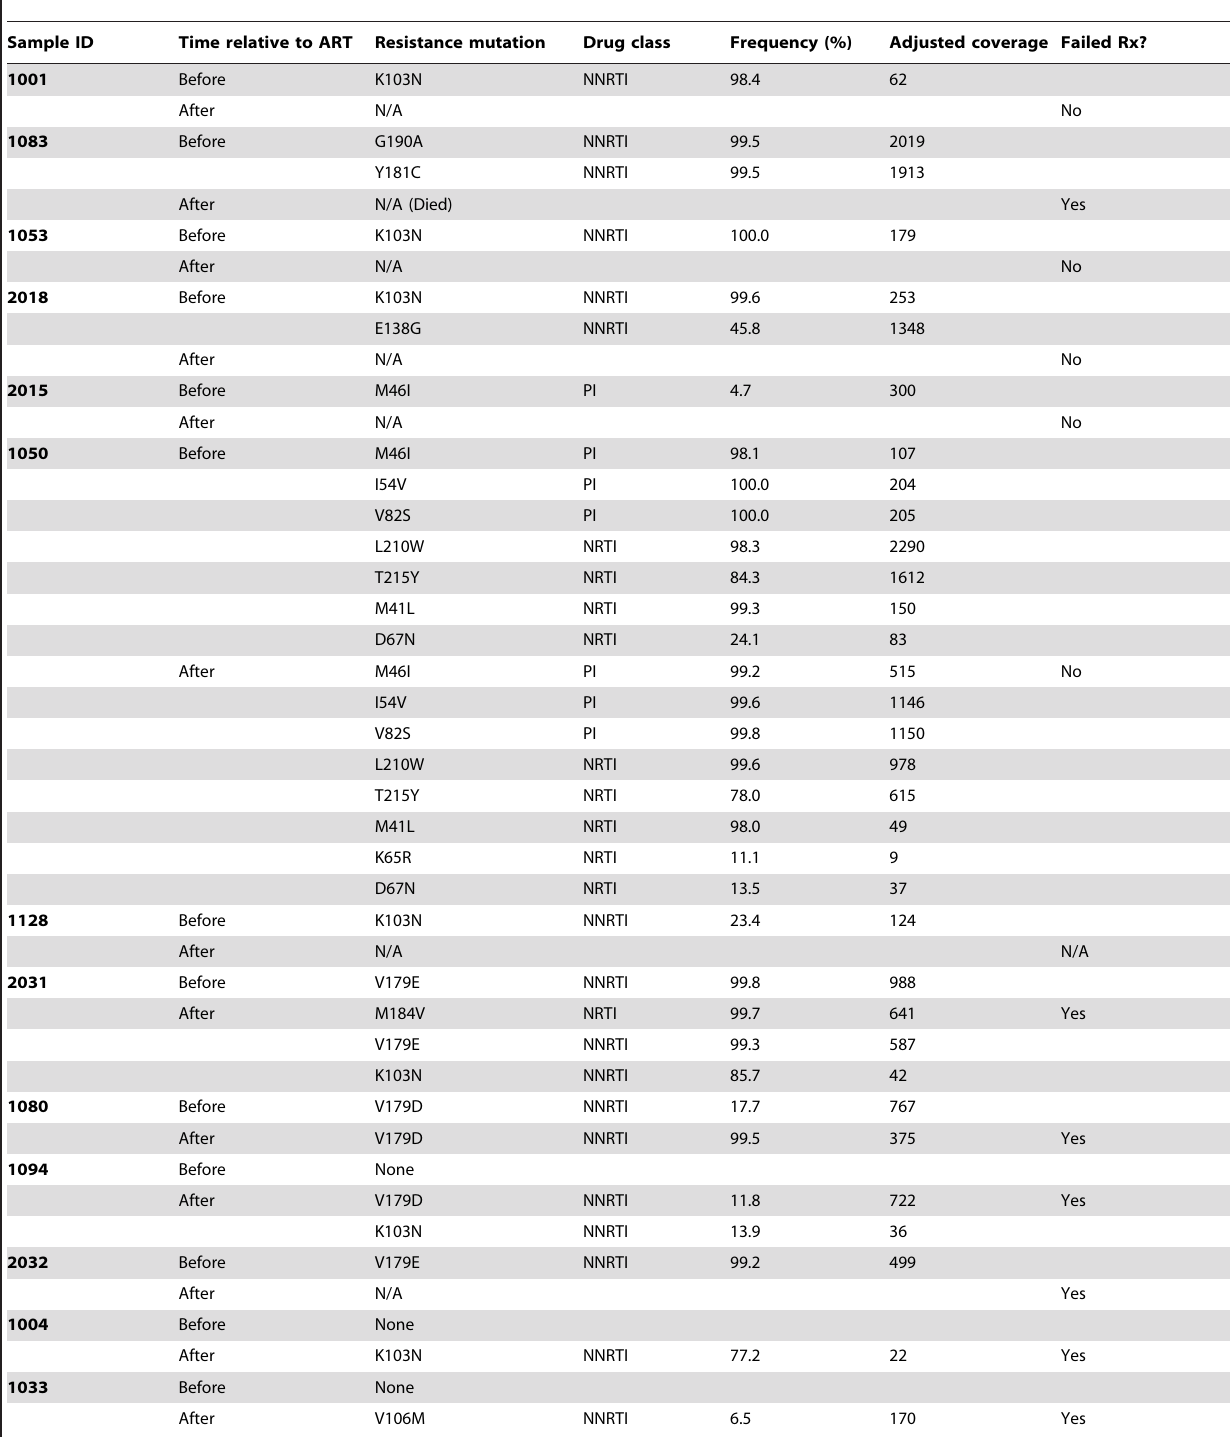
Table 3. Drug resistance mutations identified in the patient samples sequenced using the Roche/454 GS Junior HIV drug resistance genotyping